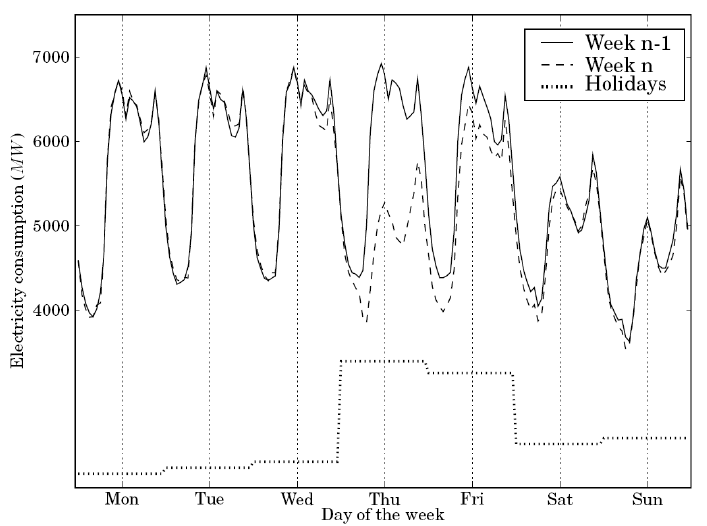
Figure 29. Snapshot of electricity consumption for Portugal for two consecutive weeks [111 ].